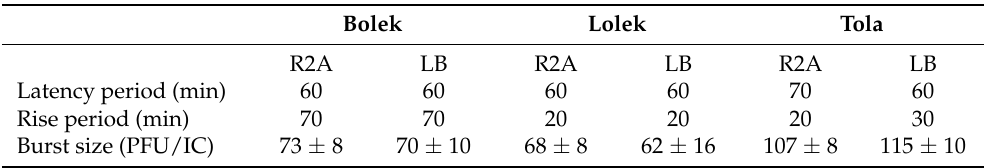
Table 2. Comparison of latency times, rise periods, and burst sizes of the Bolek, Lolek, and Tola phages in LB and R2A media at 20 ◦ C. Bolek Lolek Tola R2A LB R2A LB R2A